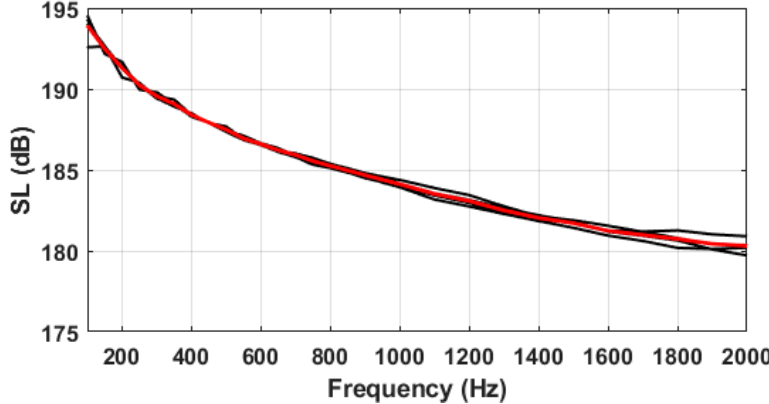
Figure 5. The source level for the central frequency 100–2000 Hz (interval 100 Hz).